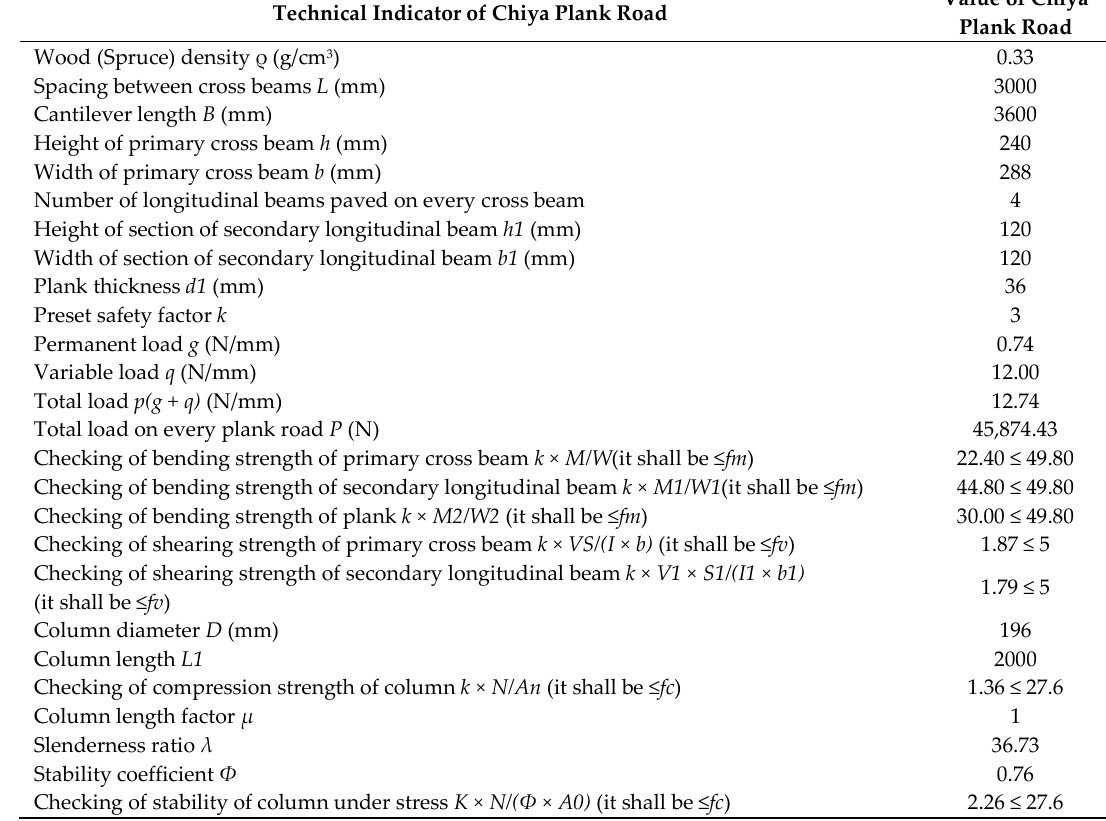
Table 2 Technical indicator and stress on the Chiya Plank Road. Technical Indicator of Chiya Plank Road